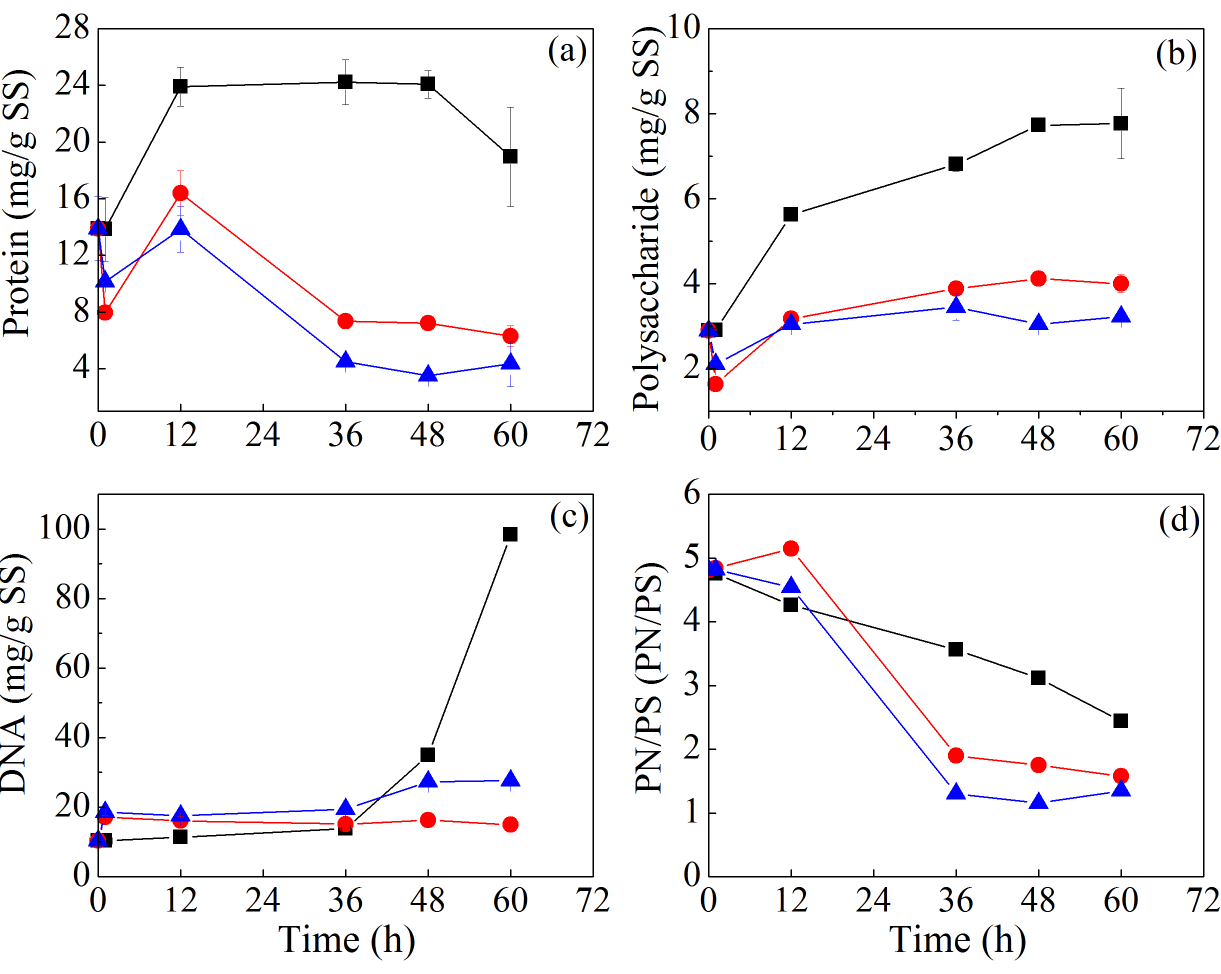
Figure 2. Variation of the content of protein (a), polysaccharide (b) and DNA (c), and PN/PS (d) in the slime during sludge bioleaching process. (PN/PS: protein/polysaccharide) ( & CK1, # CK2, g A.t + A.f